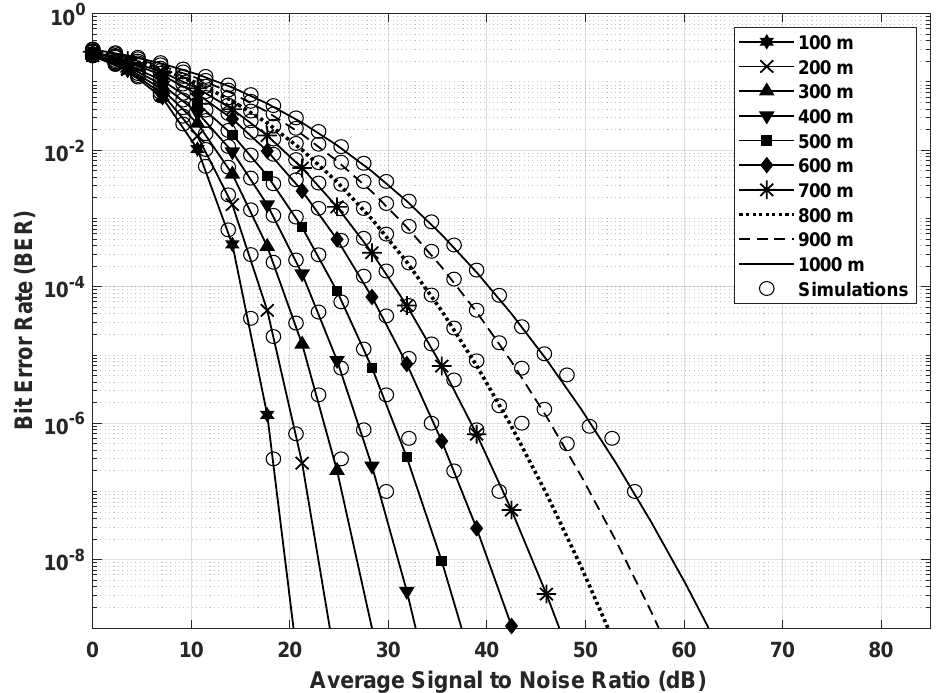
Figure 10. BER Performance for the Proposed System using OOK in Winter, Modeled using the LN Channel, for Different Propagation Distances.